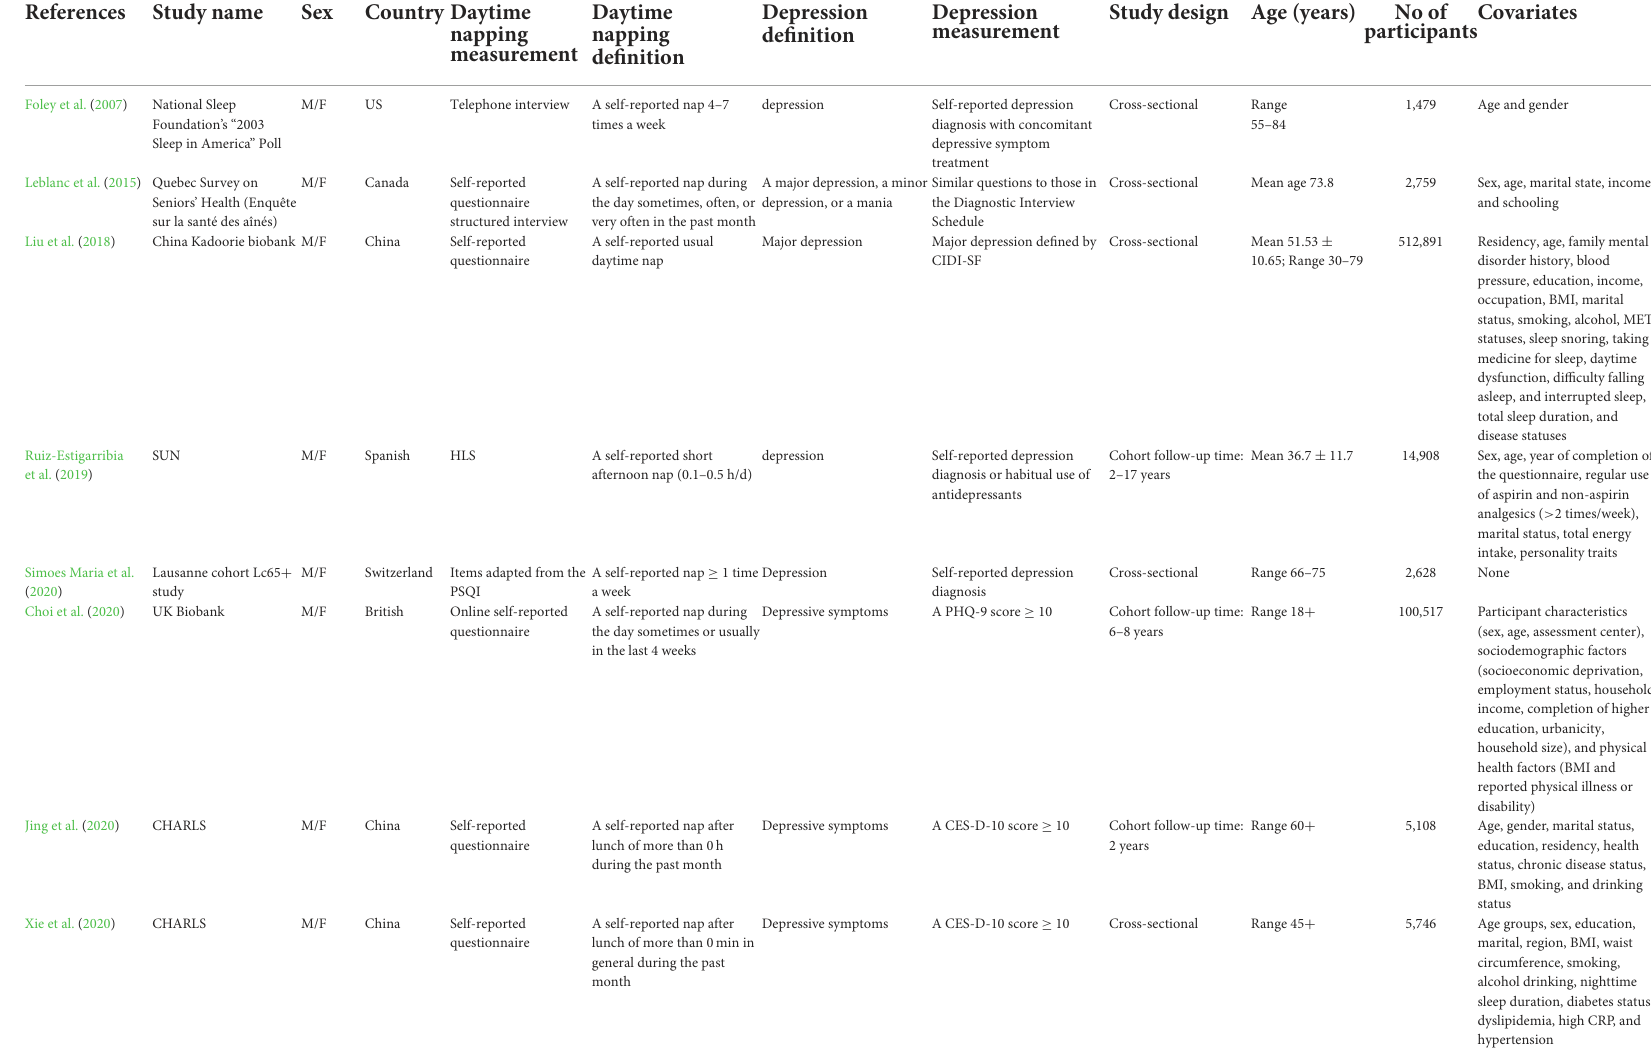
TABLE 1 Characteristics of included studies in the